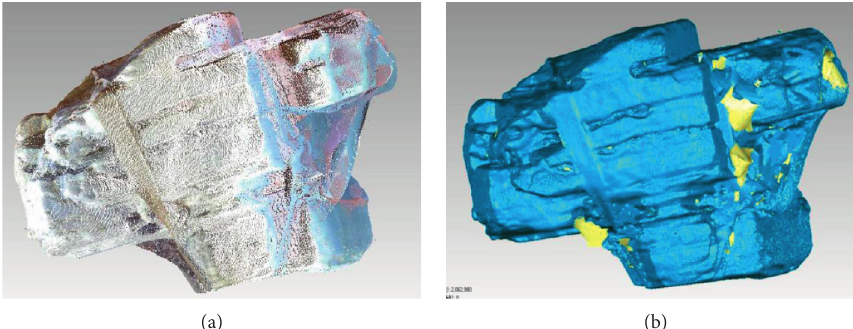
Figure 4: Error points reduction and encapsulation of cavity model. (a) Error reduction. (b) Geometric distortion after the